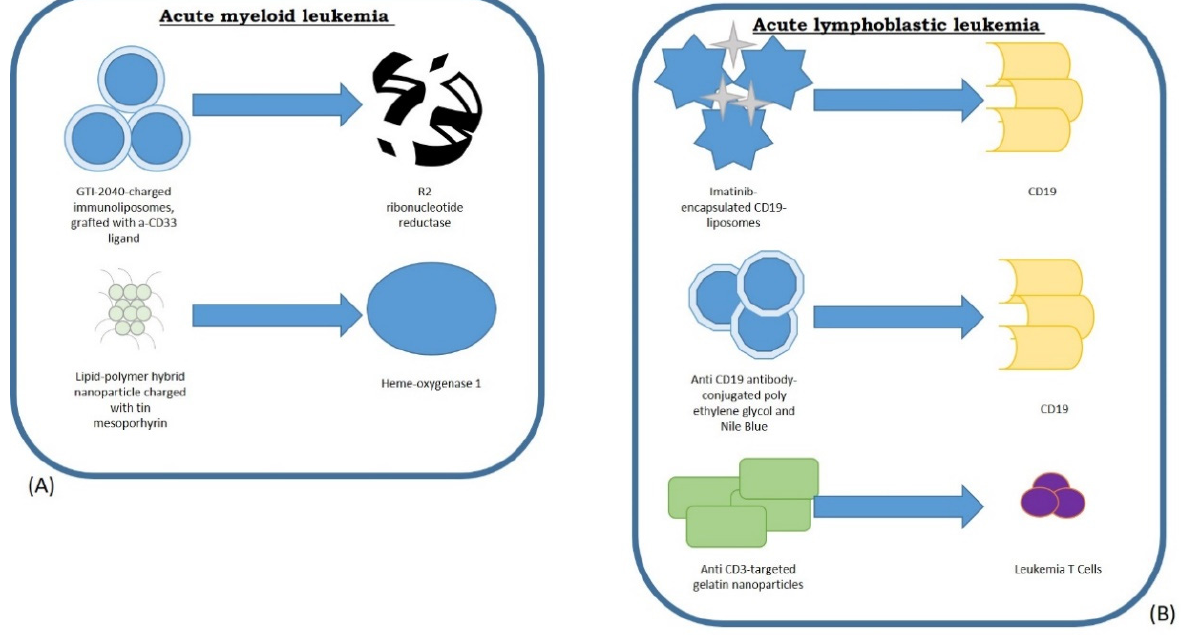
Figure 2. The use of nanoparticles permitted to recognize and aim at several targets that could be useful in acute myeloid leukemia ( A ) and ( B ) acute lymphoblastic leukemia.